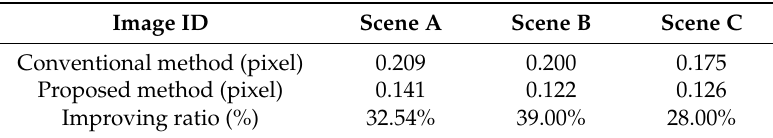
Figure 15. The side views of the parallax images (blue dots) and refined parallax images (red dots) between B1 and B2 of ( a ) Scene A, ( b ) Scene B, and ( c ) Scene C. Table 12. Detection accuracy comparison.